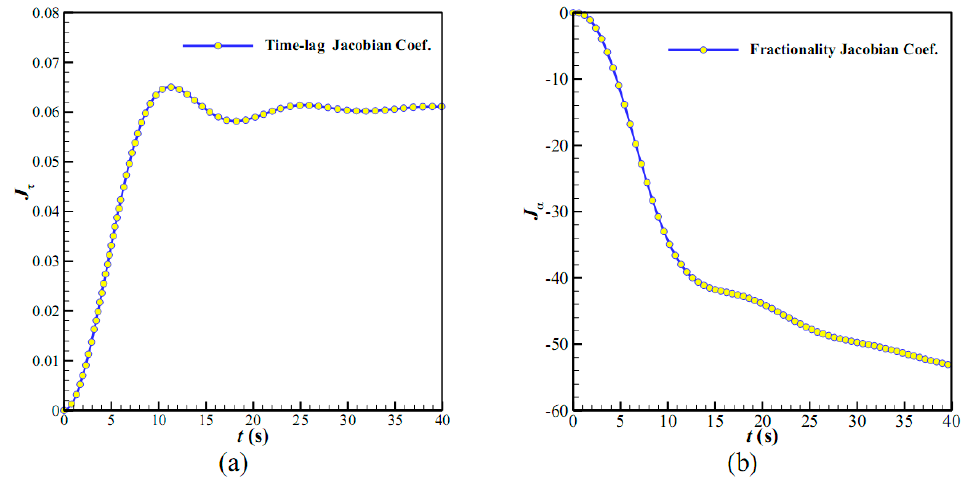
Figure 4. Jacobian coefficient for test case 1; ( a ) time-lag Jacobian coefficient and ( b ) fractionality Jacobian coefficient.